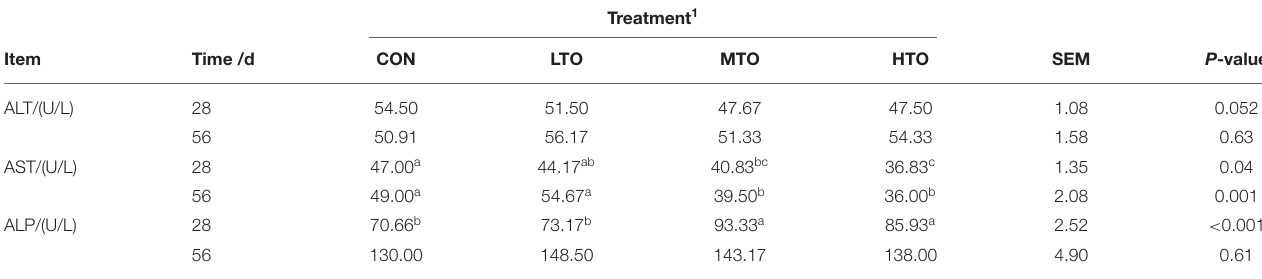
TABLE 5 | Effects of tea tree oil on the serum enzyme of finishing pigs ( n = 6).